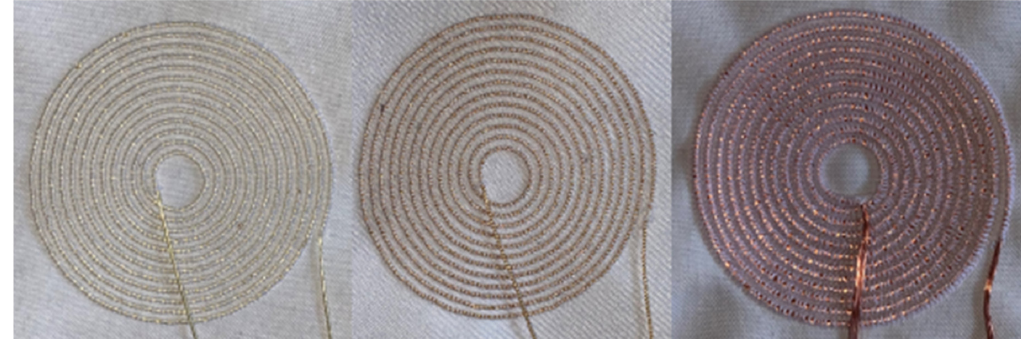
Figure 2. Embroidered coils with a diameter of 60 mm (from left to right) 60E12 ELITEX, 60U12 wrapping yarn, 60L12 copper